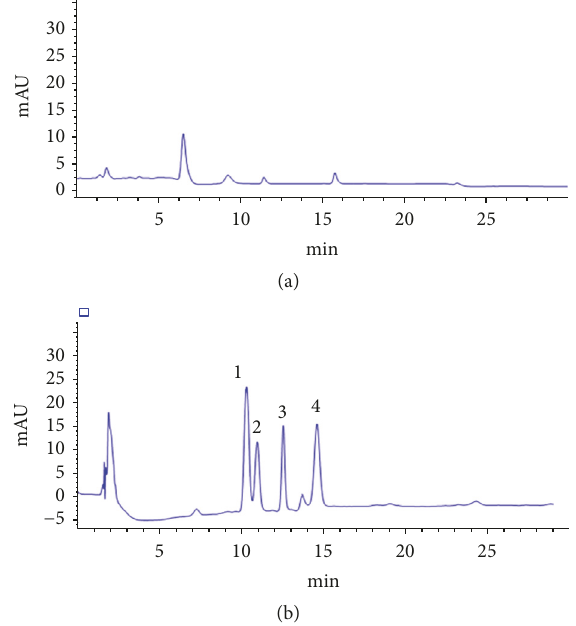
Figure 8: HPLC chromatograms of (a) the blank Paris polyphylla sample after MSPE (b) and the Paris polyphylla sample spiked with 50 ng g −1 of each pyrethroid, (1) fenpropathrin, (2) fenvalerate, (3) deltamethrin, (4) bifenthrin, after